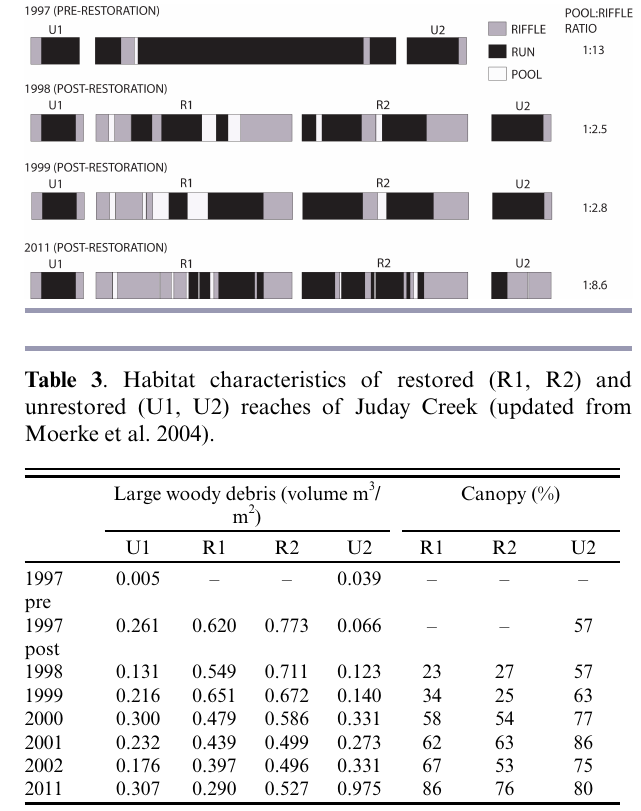
Fig. 2 . Habitat surveys in 2011 showed a lower pool:riffle ratio since restoration and an increase in the amount of riffle habitat. Pool-riffle length ratios were calculated for the entire 1-km study reach after restoration. Figure modified and updated from Moerke (2004).